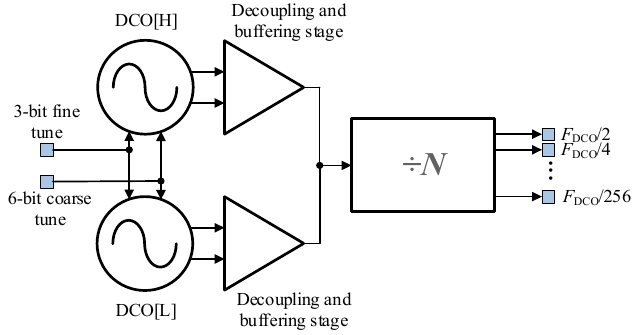
Figure 8. Structure of 5 GHz LC digitally controlled oscillator.